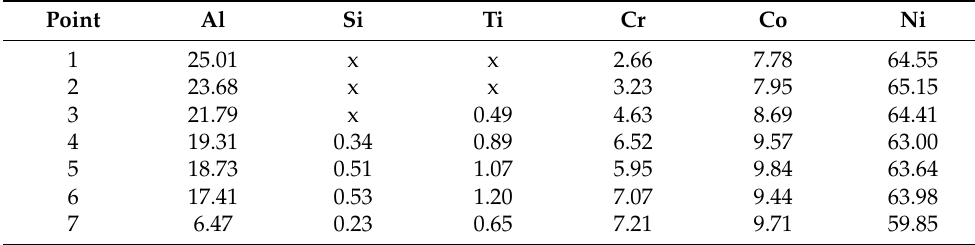
Figure 4. Microstructure of 40 µm NiAl coating produced by the CVD method on the MAR 247 nickel superalloy at 1040 °C with points of EDS analysis marked on crack propagation area. Table 2. Chemical composition (wt. %) of coating surface obtained after deposition at 1040 °C.